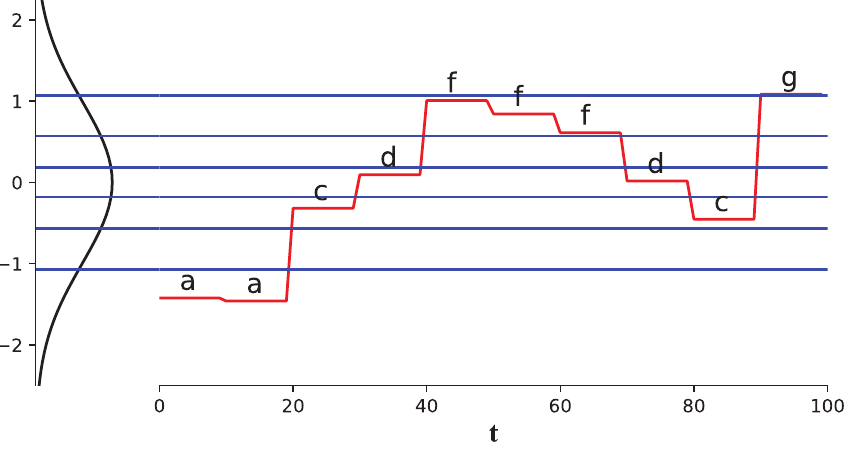
Figure 2. The PAA-MTS and SAX-MTS for NO 2 .